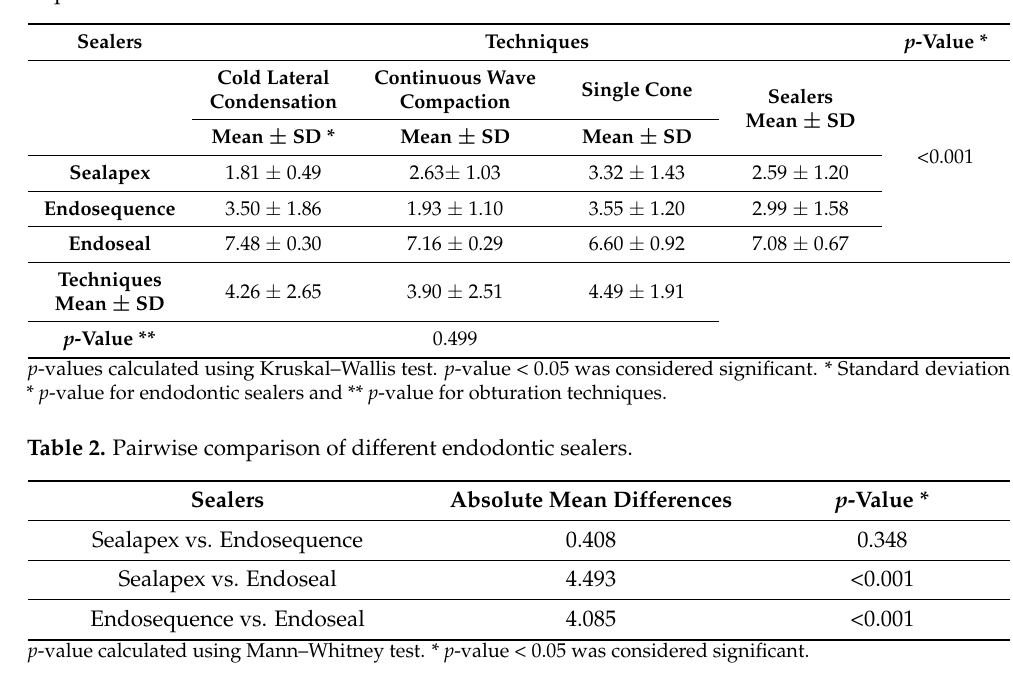
Table 1. Means and standard deviations of apical microleakage of all endodontic sealers and tech- niques.